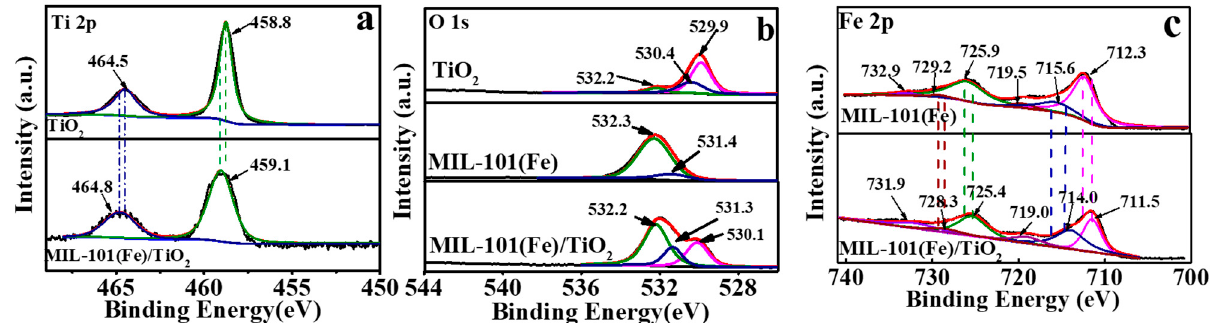
Figure 3. ( a ) High-resolution of Ti 2p spectra of TiO 2 and MIL-101(Fe)/TiO 2 ; ( b ) High-resolution of O 1s of various photocatalysts; ( c ) High-resolution of Fe 2p of MIL-101(Fe) and MIL-101(Fe)/TiO 2